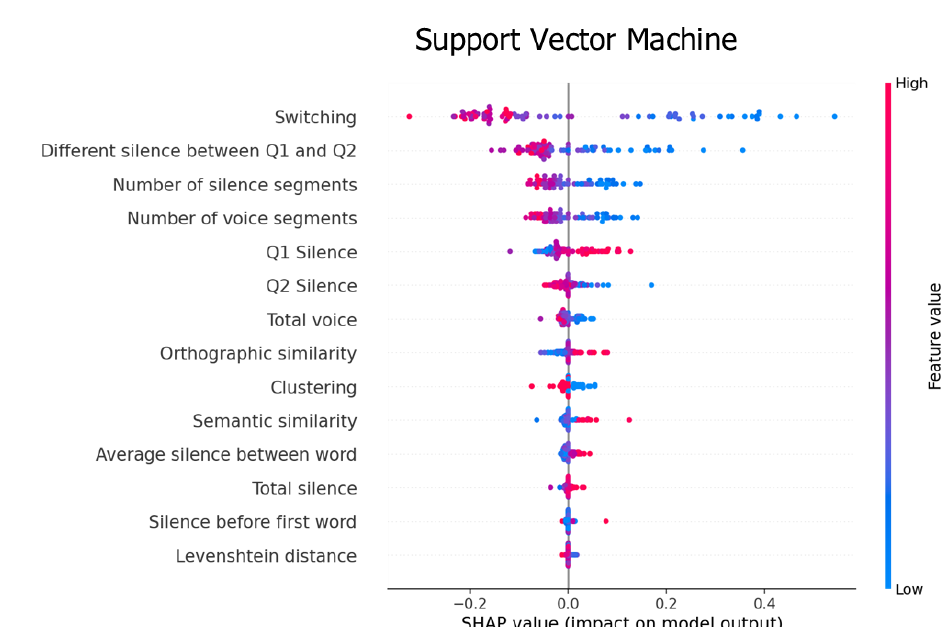
Figure 7. Feature importance explained by the SHAP value for the SVM classifier. Figure 7 . Feature importance explained by the SHAP value for the SVM classifier.